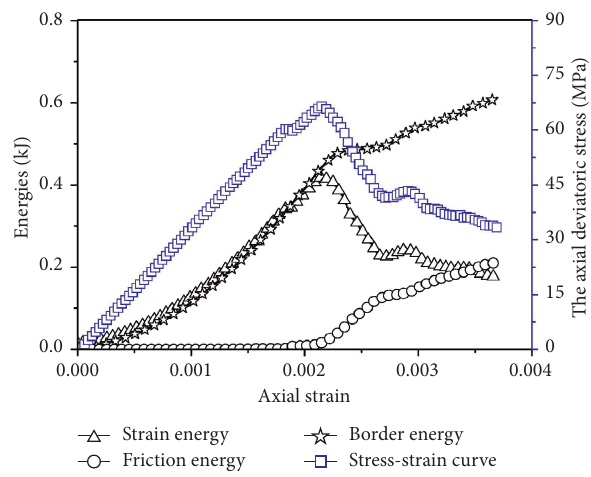
Figure 10: The changes of different